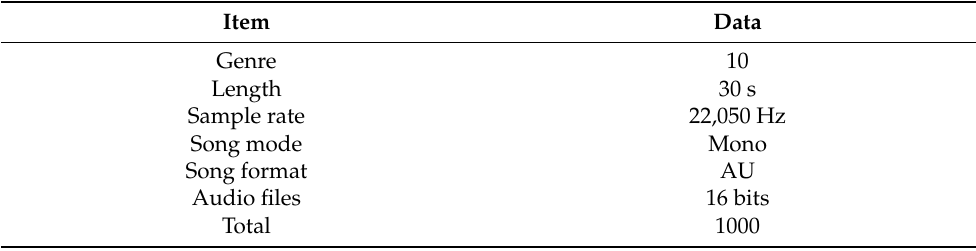
Table 1. Contents of GTZAN dataset.